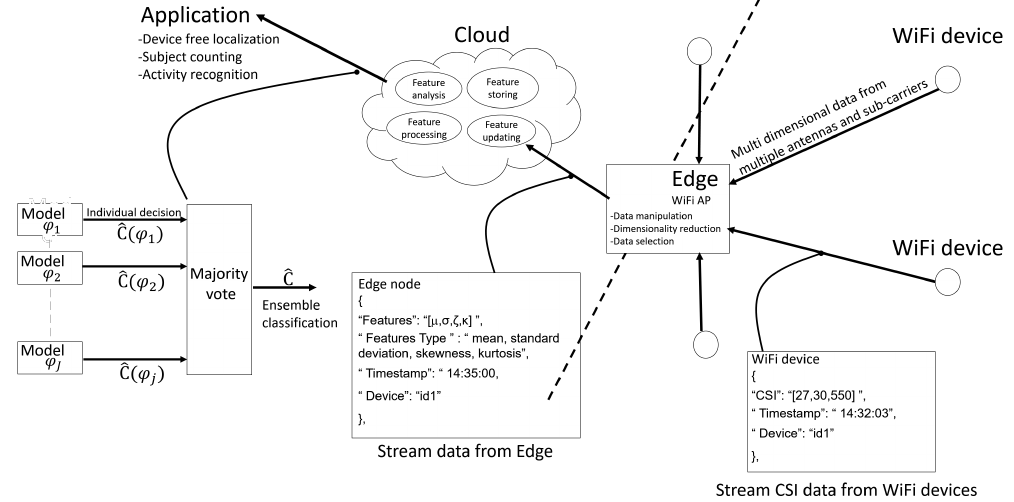
Figure 6. Edge-cloud computing architecture for CSI data manipulation, feature processing and subject